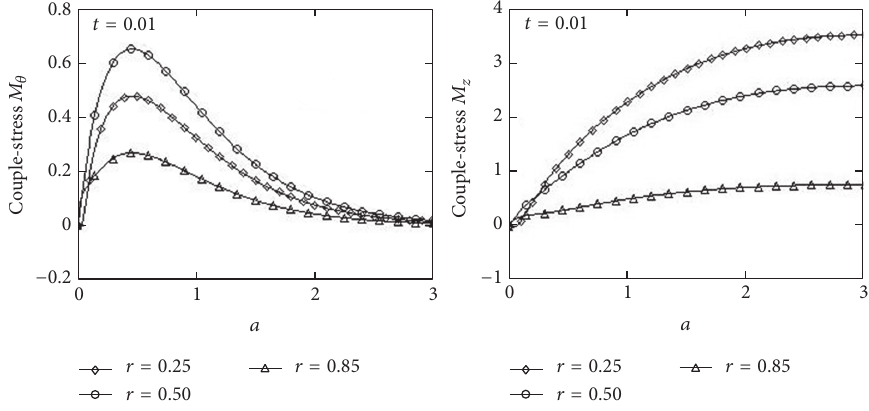
Figure 5: Variation of the couple stress with the scale parameter 𝑎 .